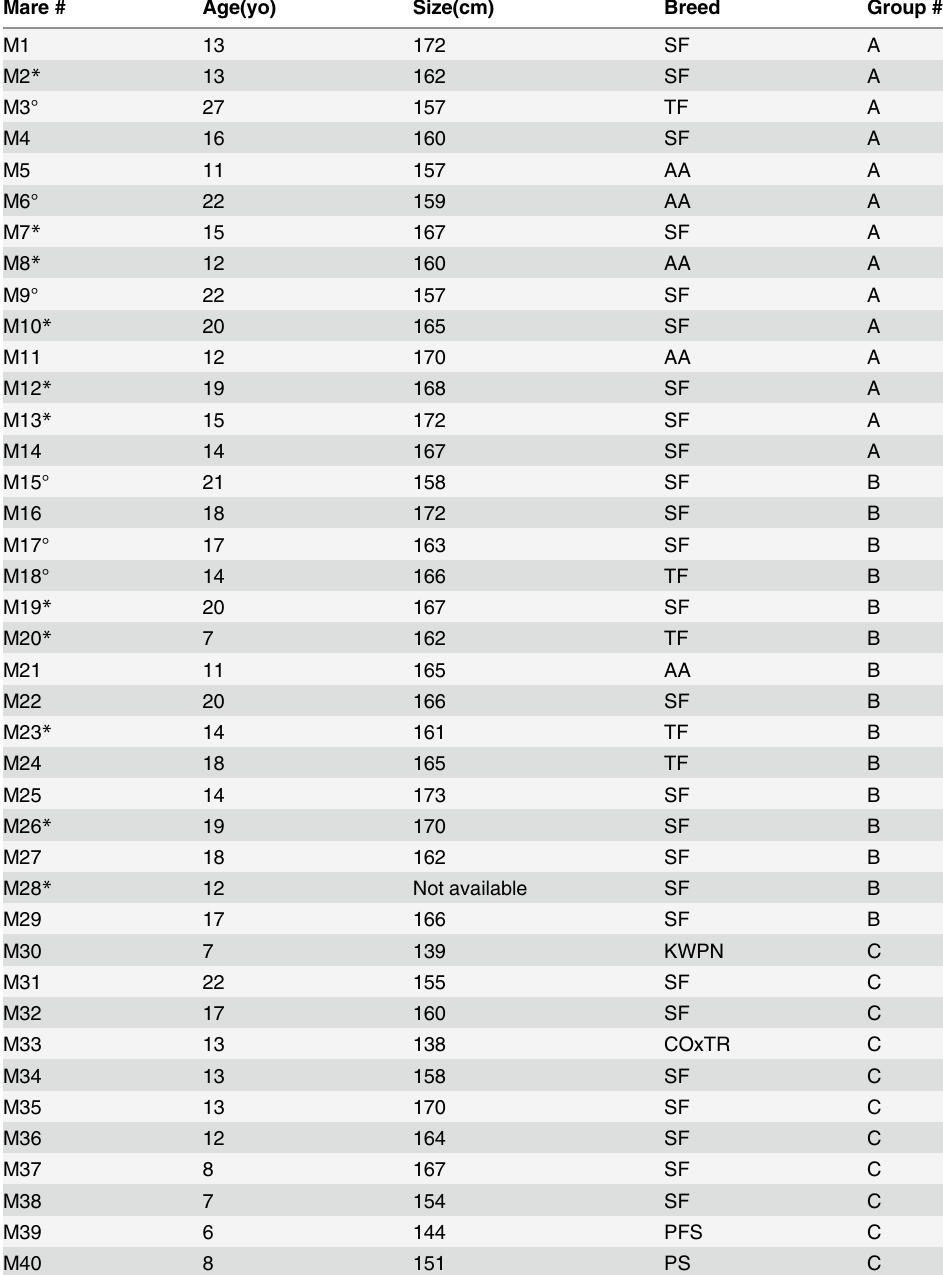
The size corresponds to the horse withers height. Estrus and anestrus females are respectively marked with * and °. Size: withers height. Females in estrus are marked with an asterisk. Breeds: SF = French saddlebred; TR = French trotter; AA = Anglo-Arabian; KWPN = Dutch warmblood; CO = Connemara; PFS = French riding pony; PS =